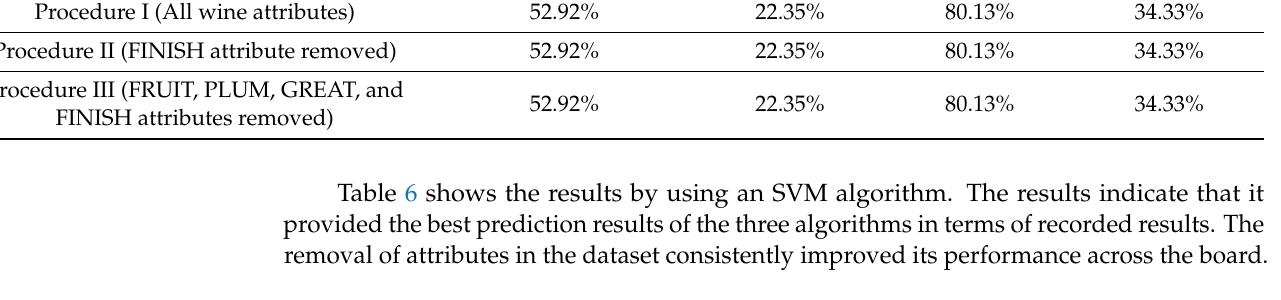
Table 6. Results of the performance of an SVM algorithm on the wine